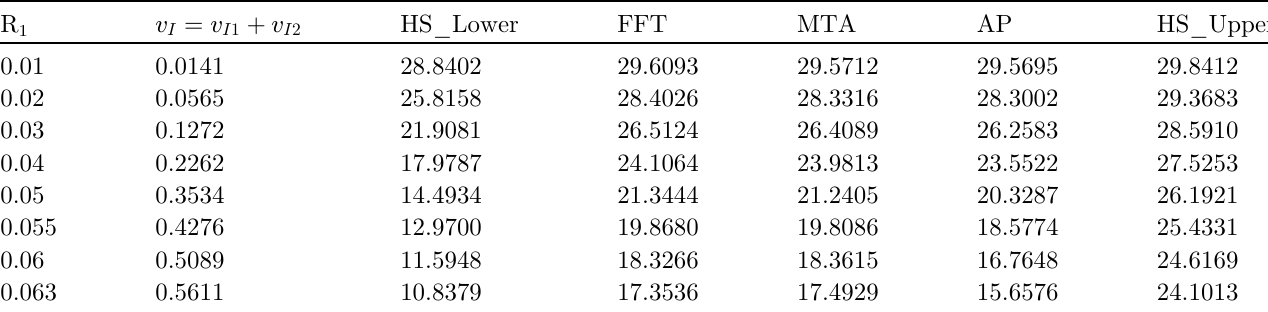
ffiffiffi p R 2 2 .